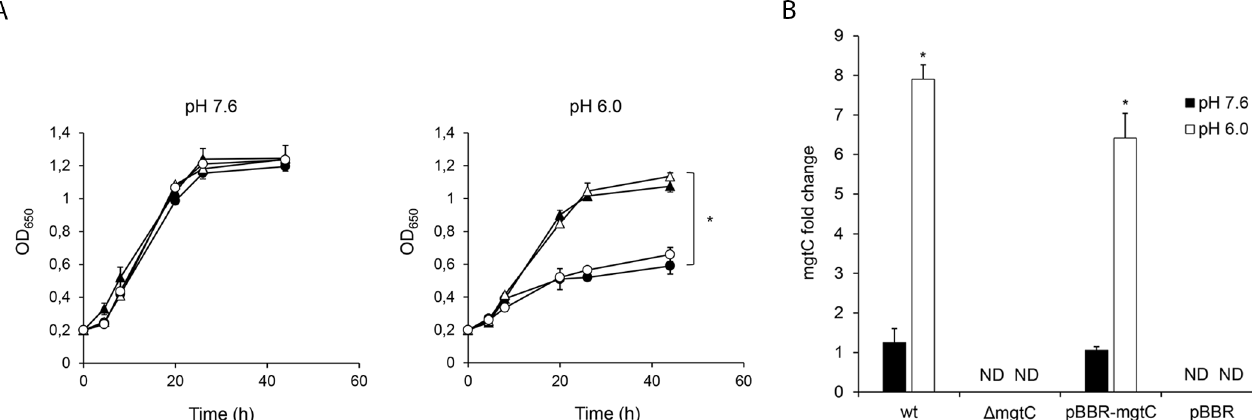
Fig 4. MgtC is required for growth in acid environments. (A) Time course of wild type B . pertussis (wt, filled triangles), B . pertussis mgtC deficient mutant ( Δ mgtC ,filled circles), B . pertussismgtC deficient mutant carrying the pBBR1MCS vector (pBBR, open circles), and B . pertussis mgtC deficient mutant carrying